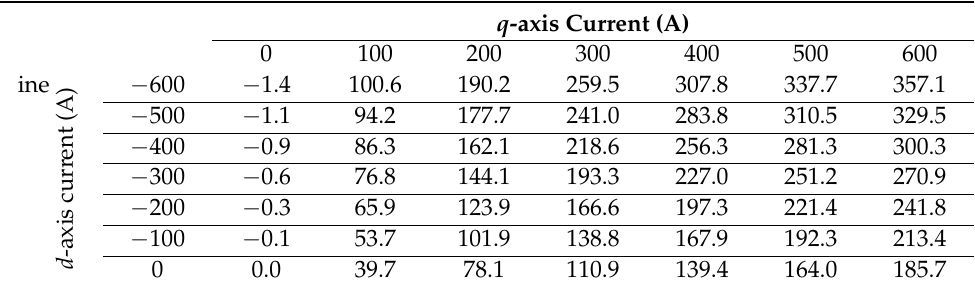
Table A6. Machine torque calculated with the FEM model (Nm) (values averaged over one electrical